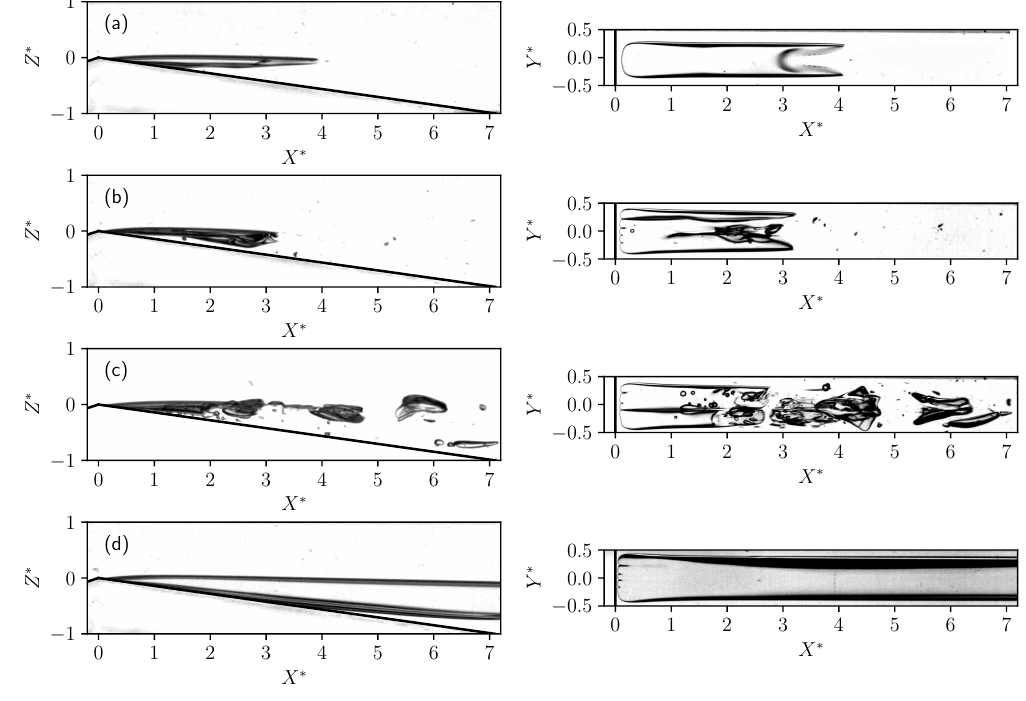
Figure 7. Side and top views in different regimes. ( a ): type-1 steady cavity ( and σ 2 = 0.51. ( b ): type-2 cavity with periodic shrinking ( (cid:4) ) at Re = 1614, σ 1 = 4.87 and σ 2 = 0.92. ( c ): type-3 unsteady cavity with no clear periodic behavior ( ( d ): to type-4 supercavity ( (cid:7) ) at Re = 1810, σ 1 = 4.66 and σ 2 =